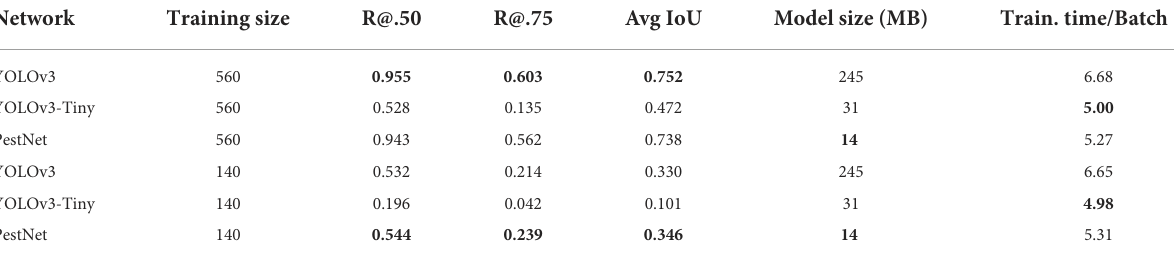
TABLE 1 Baseline YOLO performance (no augmentation).